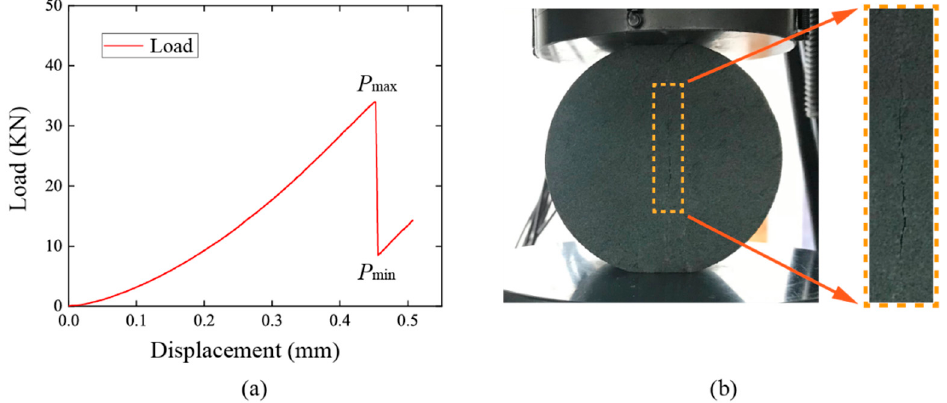
Figure 3. Splitting tests on naturally saturated FBD specimens under quasistatic loads: ( a ) load– displacement curve; ( b ) fracture behavior at disc center. Table 1. Quasistatic test results of naturally saturated sandstone specimens. Specimen No.